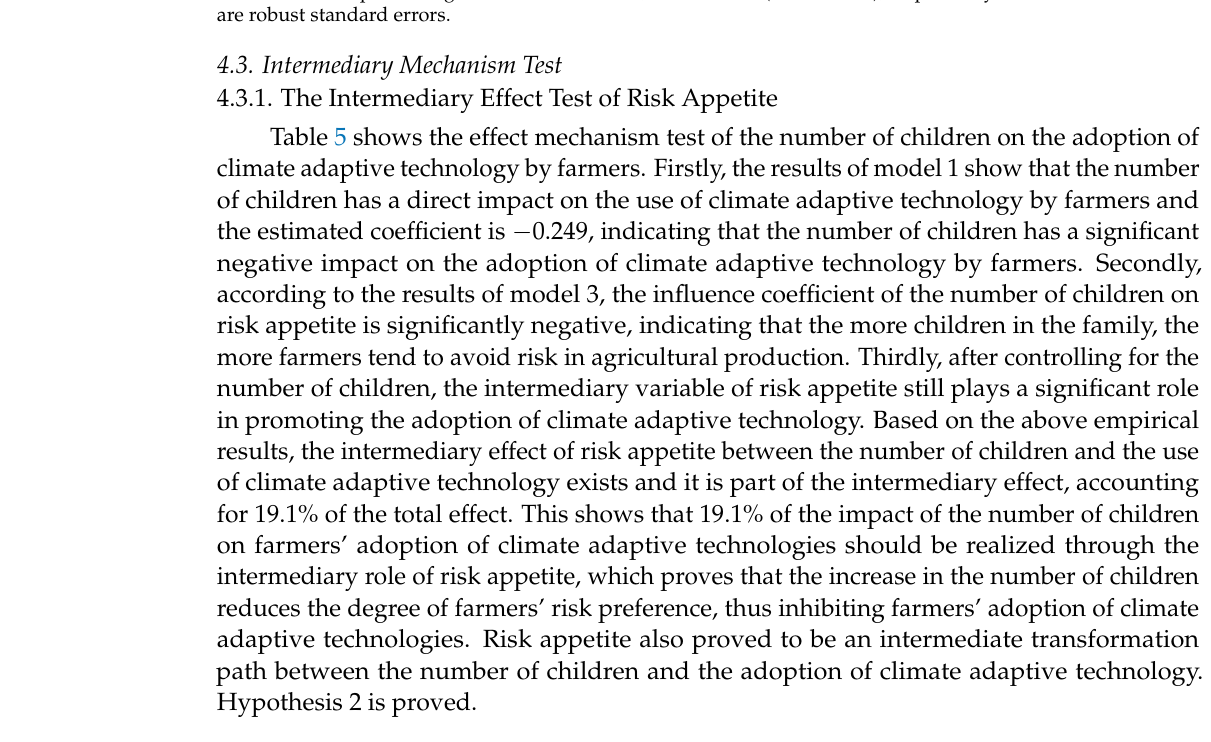
Only Child Families with Average Family Many Children Treatment Effect